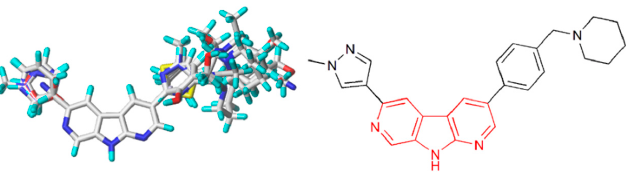
Figure 2. Common substructure (red) used in alignment, and the alignment of training structures.